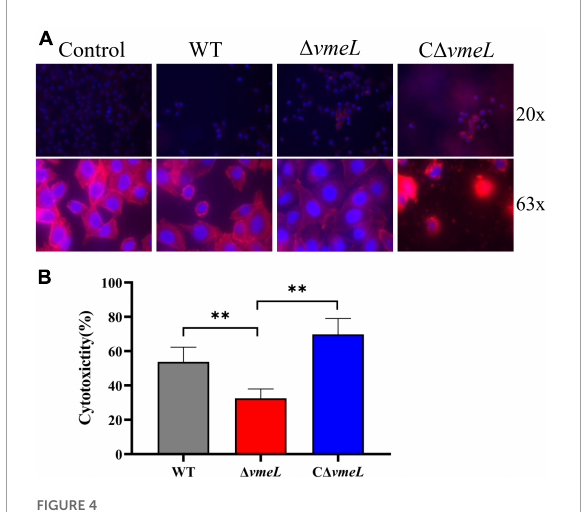
FIGURE4 VmeL-mediated virulence toward HeLa cells. (A) Representative images showed HeLa cells infected with WT, (cid:49) vmeL , and C (cid:49) vmeL strains, and one uninfected control group. DNA is shown in blue, and actin is in red. The top panels were photographed at 20 x magnification and the bottom panels were photographed at 63 x magnification. (B) Lactate dehydrogenase released by HeLa cells infected with WT, (cid:49) vmeL , and C (cid:49) vmeL strains of Vibrio parahaemolyticus were tested at 2 h. Data represent the means of six replicates. WT, wild-type; (cid:49) vmeL , vmeL deletion mutant; C (cid:49) vmeL , deletion mutant complemented strain. ∗∗ indicates statistical significance at P <